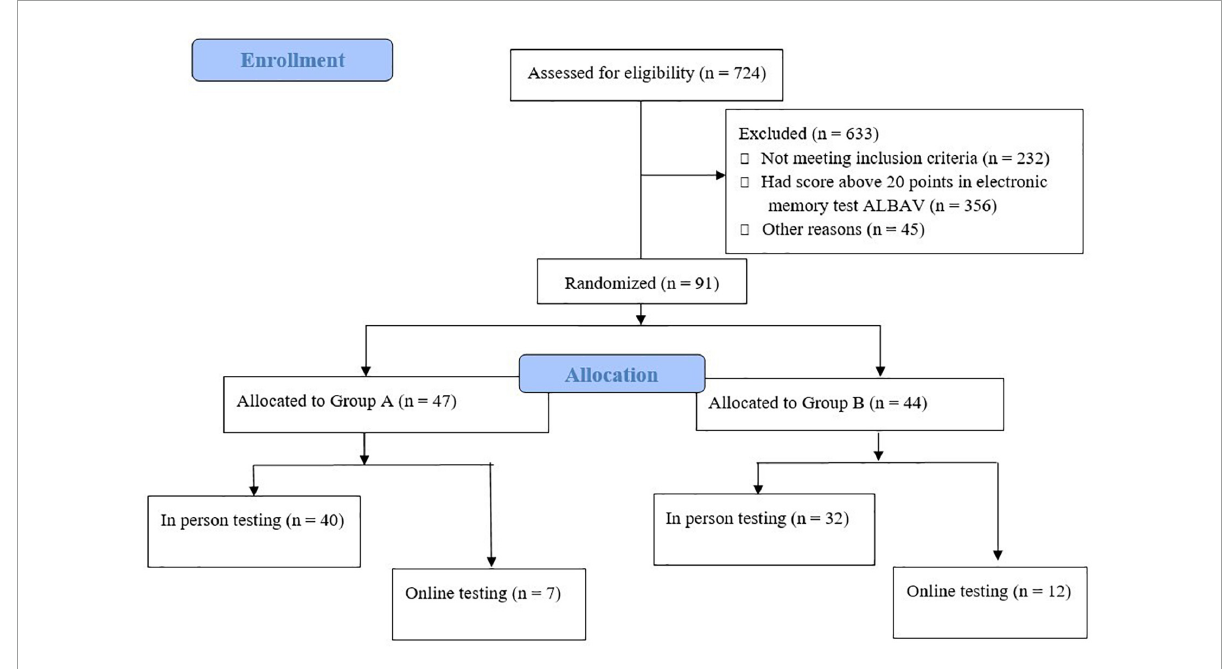
FIGURE1 Participant recruitment and allocation flowchart.